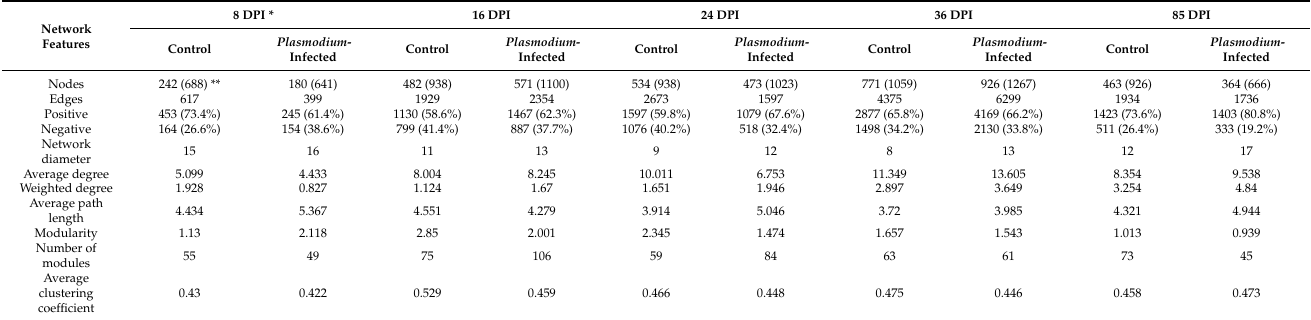
Table 1. Topological parameters of co-occurrence